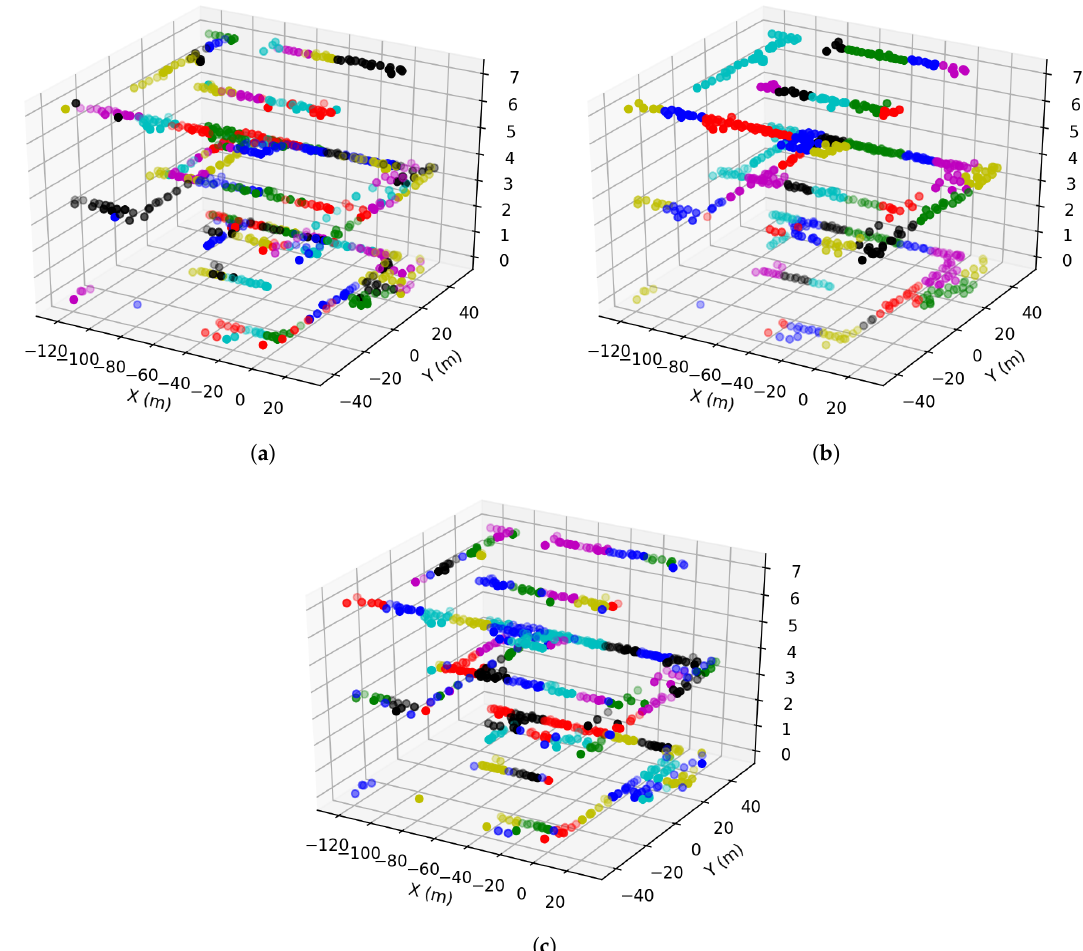
Figure 3. An illustration for clusters adopting different strategies for the same dataset. Different colors possibly denotes different clusters. The numbers of clusters are 90, 25 and 79 respectively. ( a ) RSS clustering using affinity propagation. ( b ) 3-D clustering using k-means. Fingerprints on different floors can belong to the same cluster here. ( c ) 3-D clustering using simple grids. Here the grid size is 20 m × 20 m. Fingerprints in different floors are considered belong to different